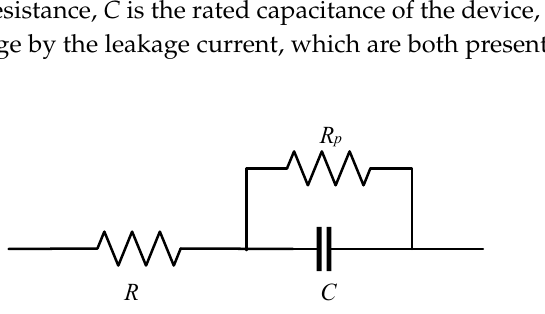
Figure 6. Classical equivalent circuit of a double layer capacitor showing its three basic characteristics: the internal resistance ( R ), its capacitance ( C ), and its self-discharge resistance ( R p ) .